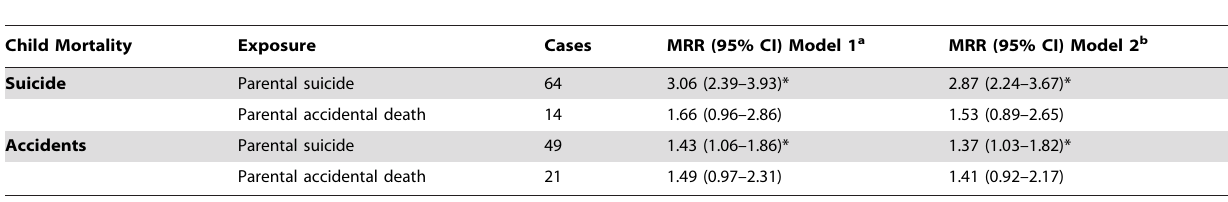
Table 7. Child suicide and accident mortality rate ratios after parental death, according to parental death from suicide and death.